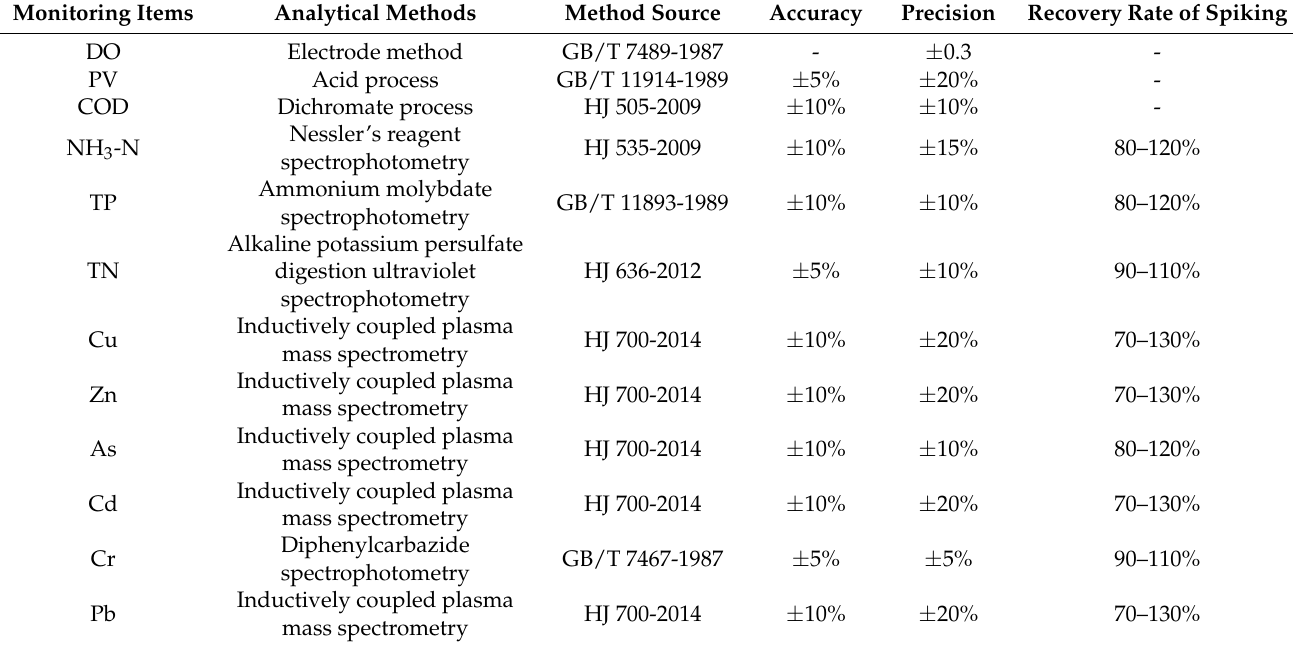
Table 2. Analysis method and quality control standard of monitoring